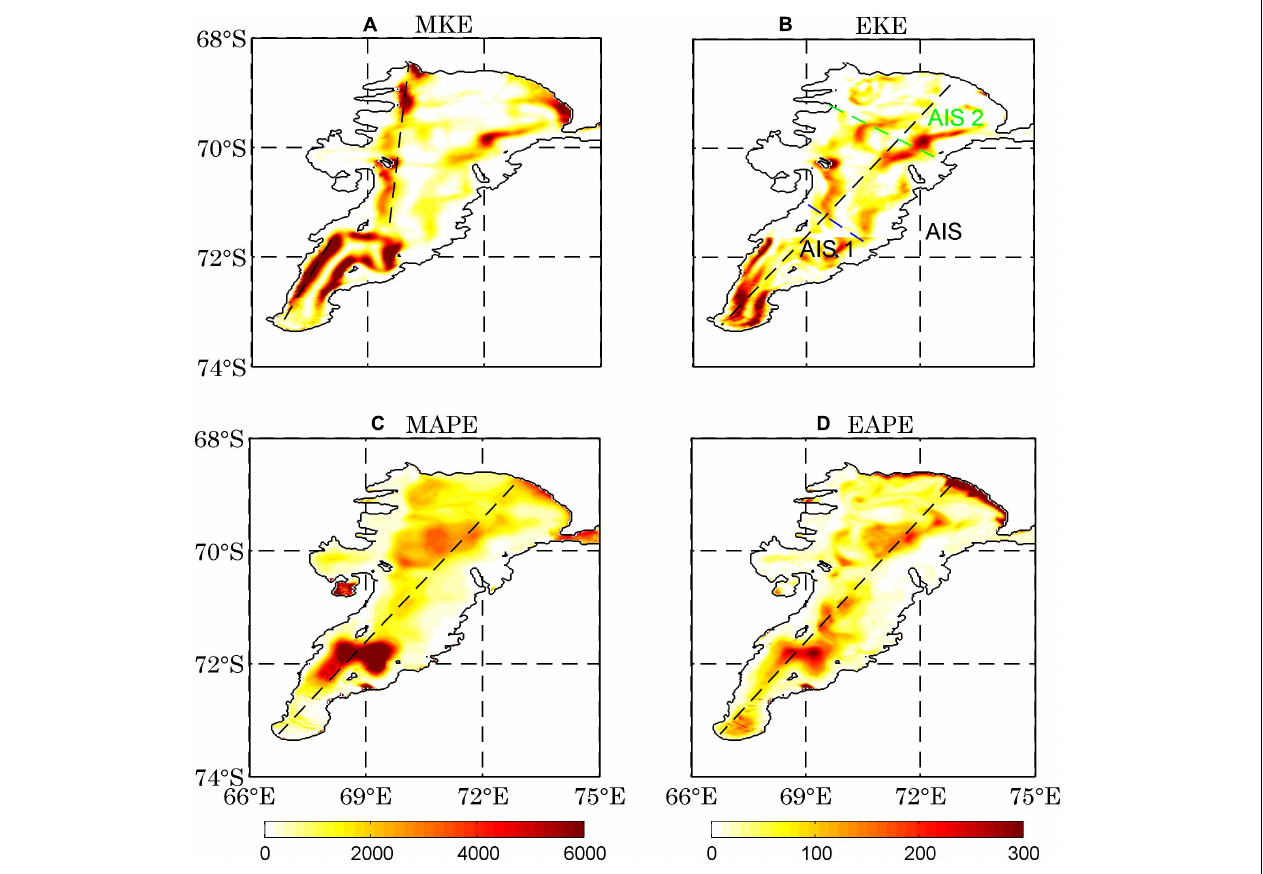
FIGURE 2 | The annual mean distributions of the vertically integrated energy components (J m − 2 ). The black dashed lines in (A–D) mark the locations of the vertical cross sections in Figure 5 . The inner and outer subdomains are outlined by the blue and green lines and marked by AIS1 and AIS2, respectively, in Figure 2B